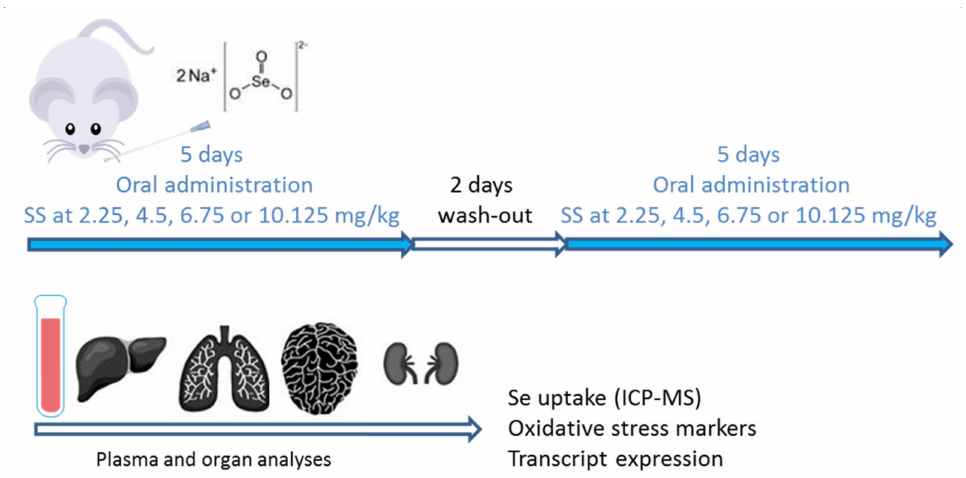
Figure 5. Experimental design to study the toxicity of SS in BALB/c